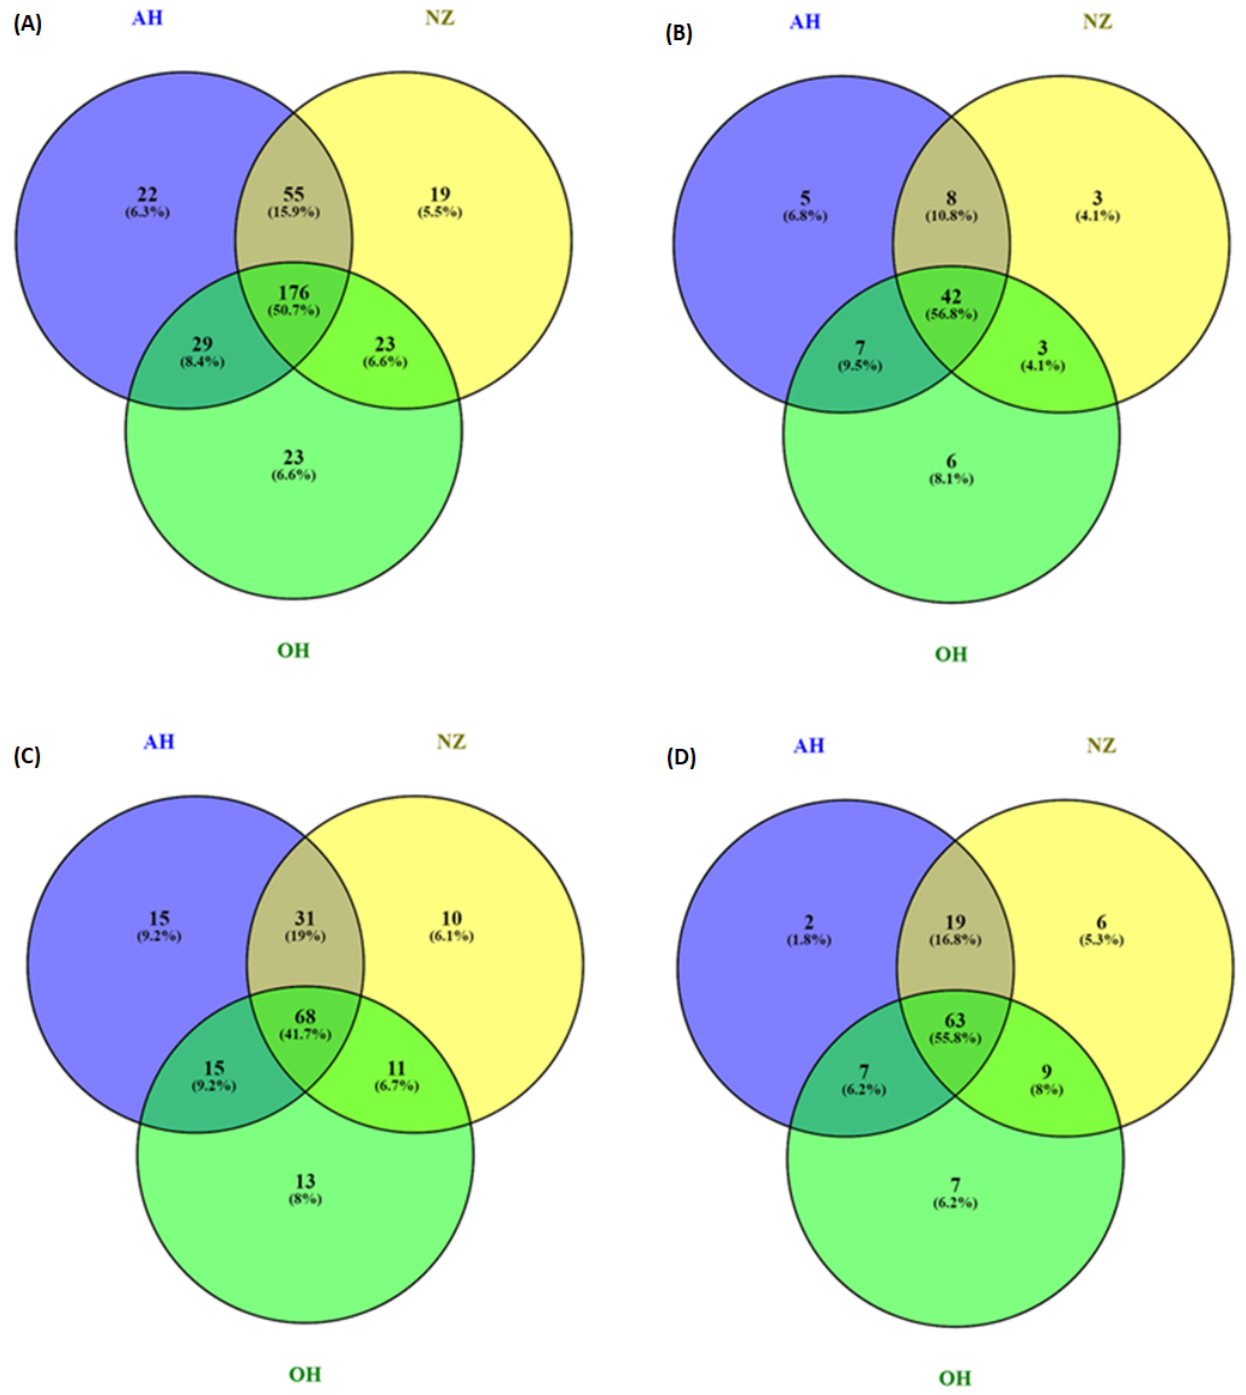
Figure 1. Venn diagram of the total phenolic compounds presented in different kiwifruit samples. ( A ) A comparison of the total phenolic compounds present in different kiwifruit cultivars. ( B ) A comparison of the total phenolic acids present in different kiwifruit cultivars. ( C ) A comparison of the total flavonoids present in different kiwifruit cultivars. ( D ) A comparison of the total other polyphenols present in different kiwifruit cultivars. AH: Australian-grown Hayward kiwifruit. NZ: New Zealand-grown Zesy002 kiwifruit. OH: New Zealand-grown organic Hayward kiwifruit.